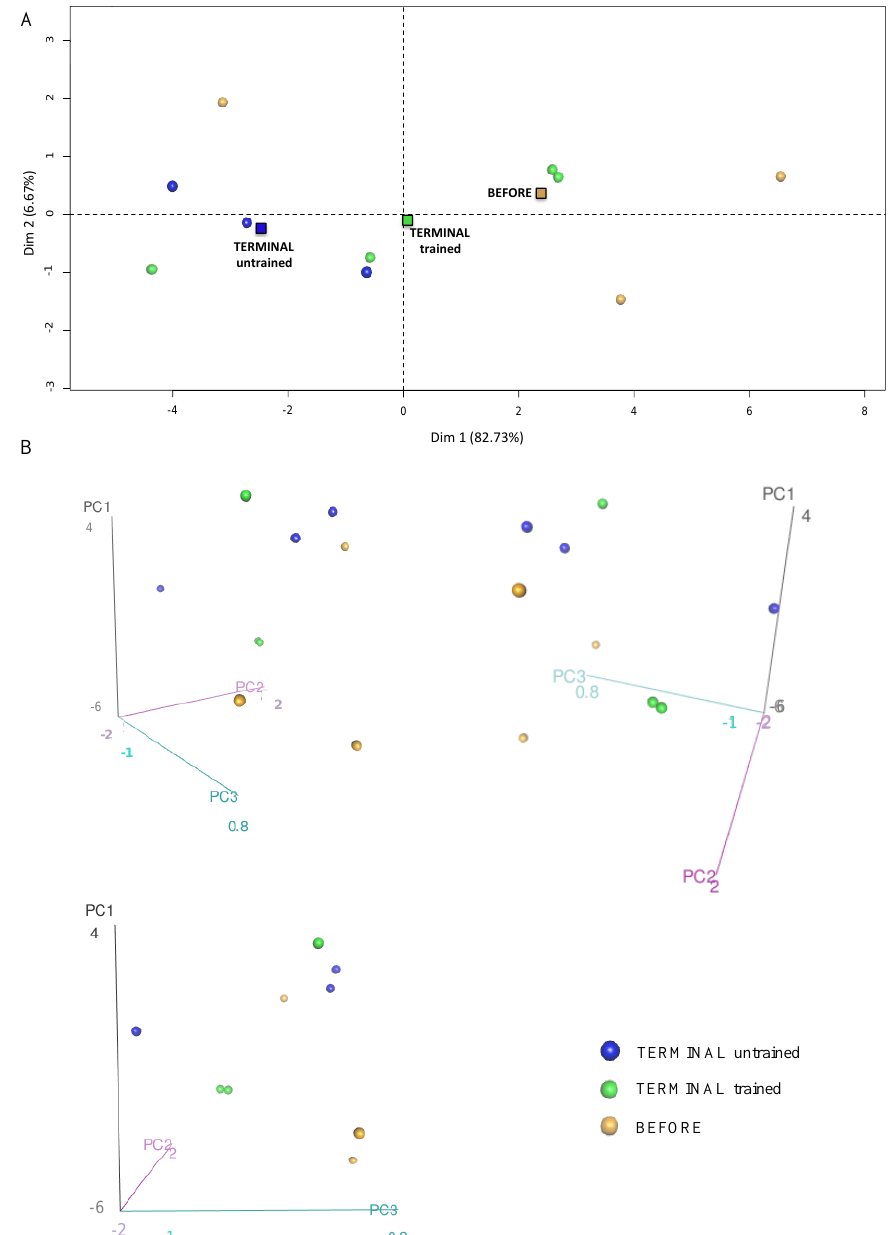
Figure 5. Principal component analysis showing differences in the glycolysis proteome profiles of the BEFORE, TERMINAL untrained, and TERMINAL trained groups: ( A ) The 2D graph of variables PC1 and PC2 created using a PCA based on the level of 16 identified proteins involved in glycolysis measured in TA muscle of ALS mice; ( B ) the 3D graphs of variables PC1, PC2, and PC3 created using a PCA based on the level of 16 identified proteins involved in glycolysis measured in the TA muscle of ALS mice. 3D individual graphs show the view from a different angle on the same distribution of events in the 3D space. The data are presented as the means (squares) and individual results (dots) ( n = 3 in each group).